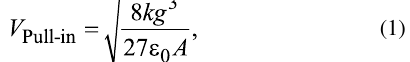
needs to be avoided in the design of microcombs [1]. Mean- while, devices using pull-in as the working mechanism have at- simple